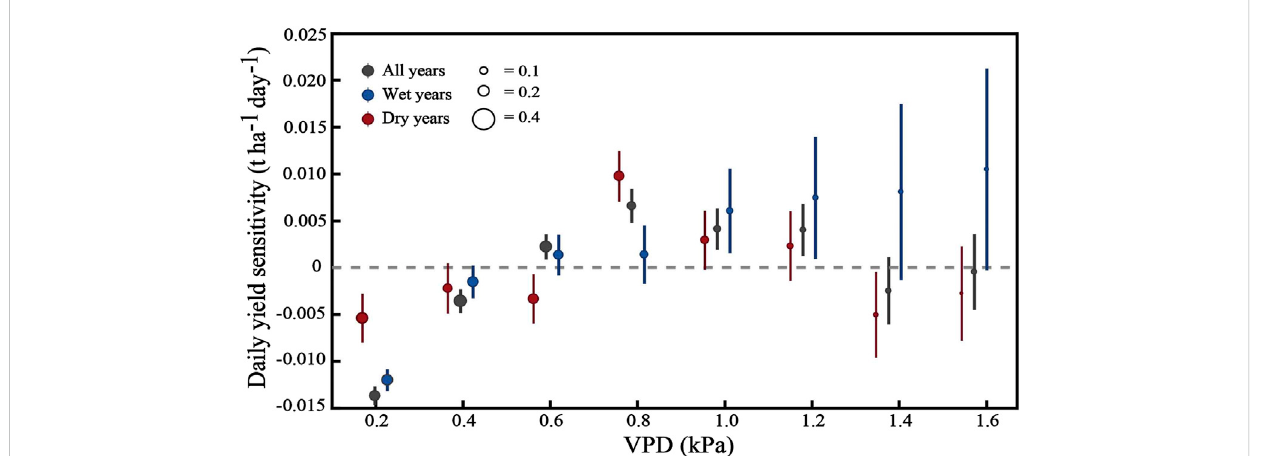
FIGURE 4 Daily sensitivity ofmaizeyields toVPD under differentsoilmoistureconditions. Eq.3estimatestheresponse ofthedriest40%(red),thewettest 40% (blue), and all grid-years (black) to the daily yield anomaly of vapor pressure de fi cit (VPD). A constant width interval from 0.4 kPa to 2 kPa is speci fi ed, and the center of the interval is marked on the horizontal axis. The size of the circles in the plot represents the percentage distribution of data that belongs to the corresponding interval in each set of data, and the vertical bar represents the 95% con fi dence interval corresponding to each sensitivity.